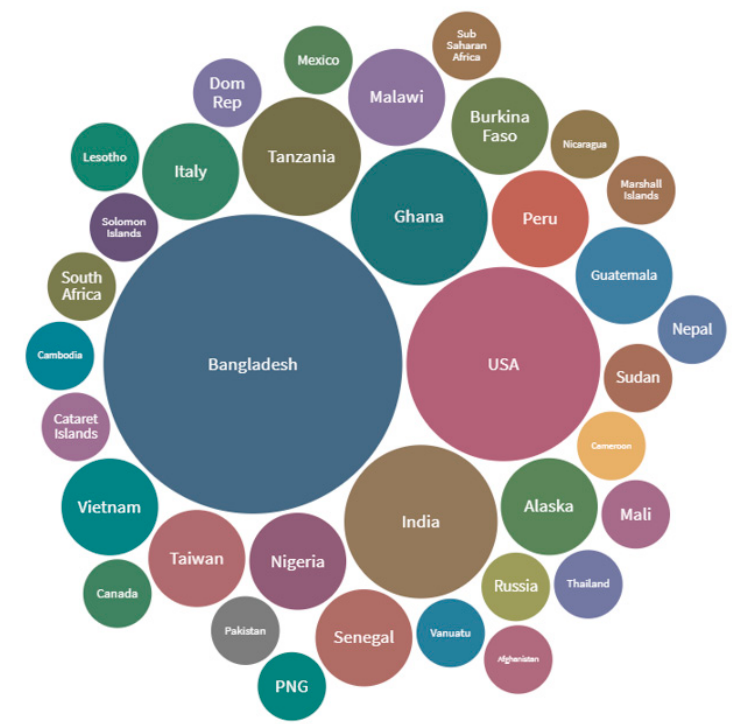
Figure 3. Study Settings. The size of bubbles indicates how many of the 68 studies were conducted in each study site (details in